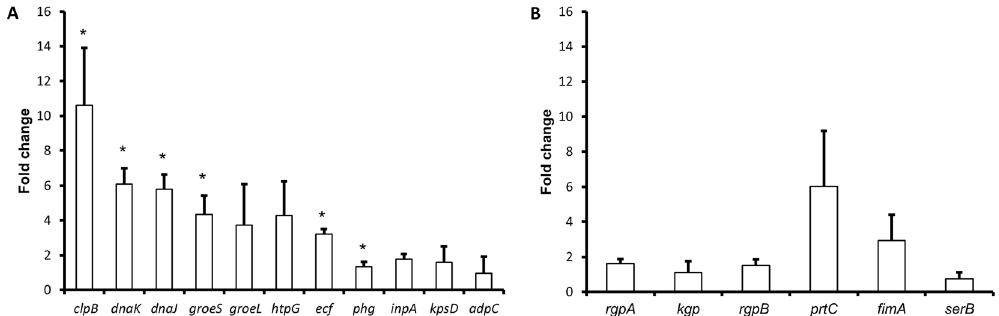
Figure 1. Expression of virulence genes from P . intermedia and P . gingivalis in presence of dead oral bacteria. ( A ) Relative fold change of virulence genes from P . intermedia after exposure to dead P . gingivalis . ( B ) Relative fold change of virulence genes from P . gingivalis after exposure to dead P . intermedia . * Designates a statistically significant up-regulation of virulence genes respect to house-keeping genes (p < 0.05).